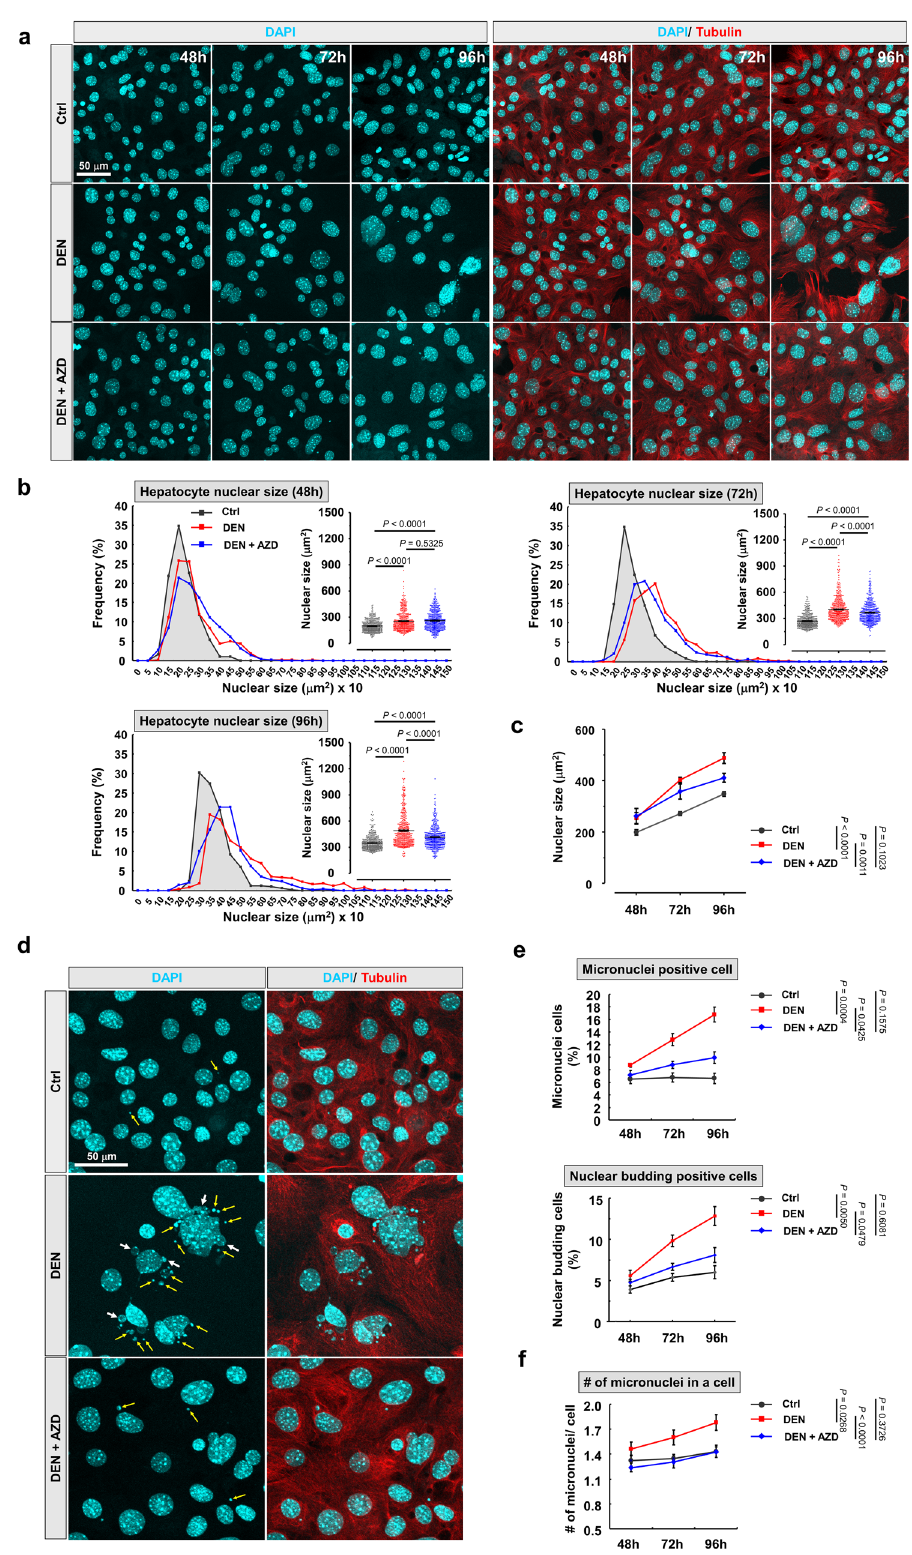
tumor-suppressive role in the liver, but pathological hyperpoly- ploidy under stress conditions is a different situation 16 . We hypothesize that, under normal conditions, polyploidy indeed suppresses tumorigenesis. Under stress, hyperpolyploid